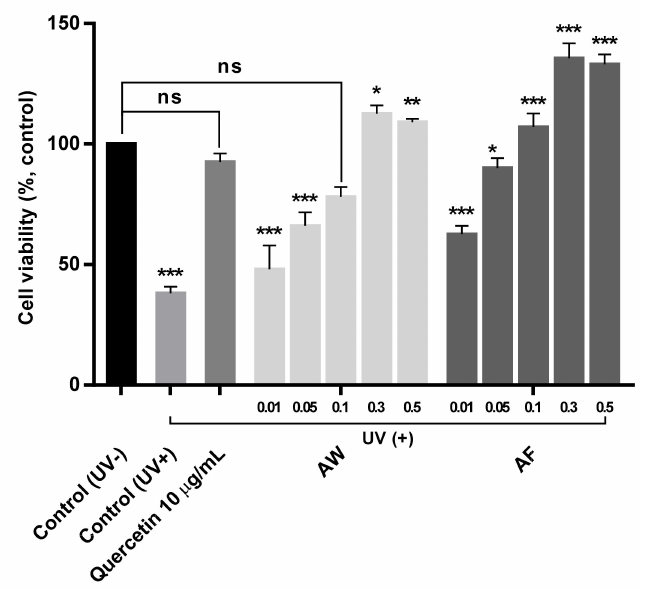
Figure 3. Comparison of mitochondrial reductase activities in UV b -irradiated human skin fibroblasts treated with 10 µ g/mL quercetin and various concentrations of the two aloe extract samples. AW: Hot water extraction of Aloe vera leaf skin at 100 ◦ C for 24 h. AF: L. plantarum fermentation of Aloe vera leaf skin at 37 ◦ C for 3 days and extraction with an ultrasonicator at 40 kHz for 1 h at room temperature. The mean values ± SD for separate triplicate experiments are shown, and the error bars represent the SD. The significance of the difference was set to * p < 0.05, ** p < 0.01 and *** p < 0.001 compared with the control (UV − )